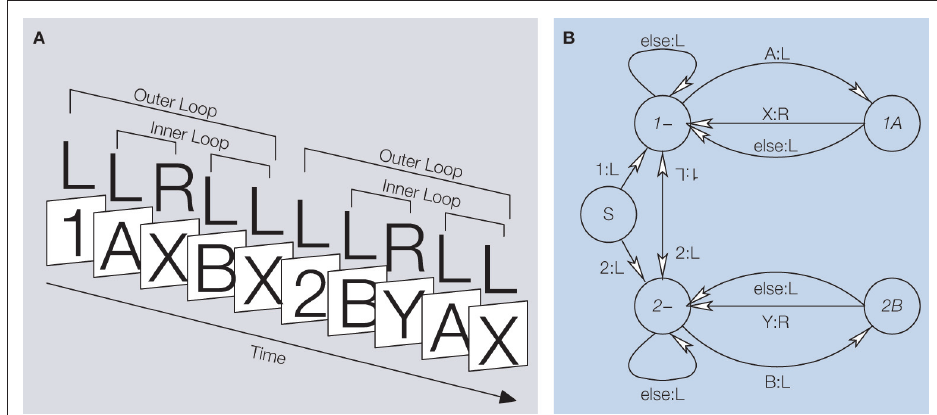
Figure 1 | The 12AX task (from O’Reilly and Frank, 2006, rendered by Krueger and Dayan, 2007 ). (A) Subjects see a sequence of numbers and letters (in boxes), and have to respond by pressing one of two keys (L or R; correct responses are shown). They should choose L every time, except to respond R if the most recent digit is a 1 and X directly follows A, or the most recent digit is a 2 and Y directly follo-ws B. There can be many AX or BY subsequences following each 1 or 2, and inner loops always involve pairs of symbols. Different variants of the task impose slightly different constraints on the symbols in the non-one-back inner loops. (B) A finite state representation of one procedural solution to the task . S is the start state; the links are labelled with the observation and the action. The main states are annotated with a representation of the contents of working memory (in italics). ‘1:L’ is upside down indicating it labels the link from 2- to 1- ; ‘2:L’ on the same arrow labels the link from 1- to 2-